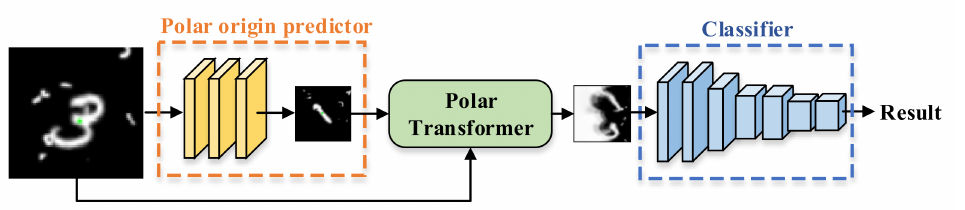
Figure 13. Architecture of polar transformer network.